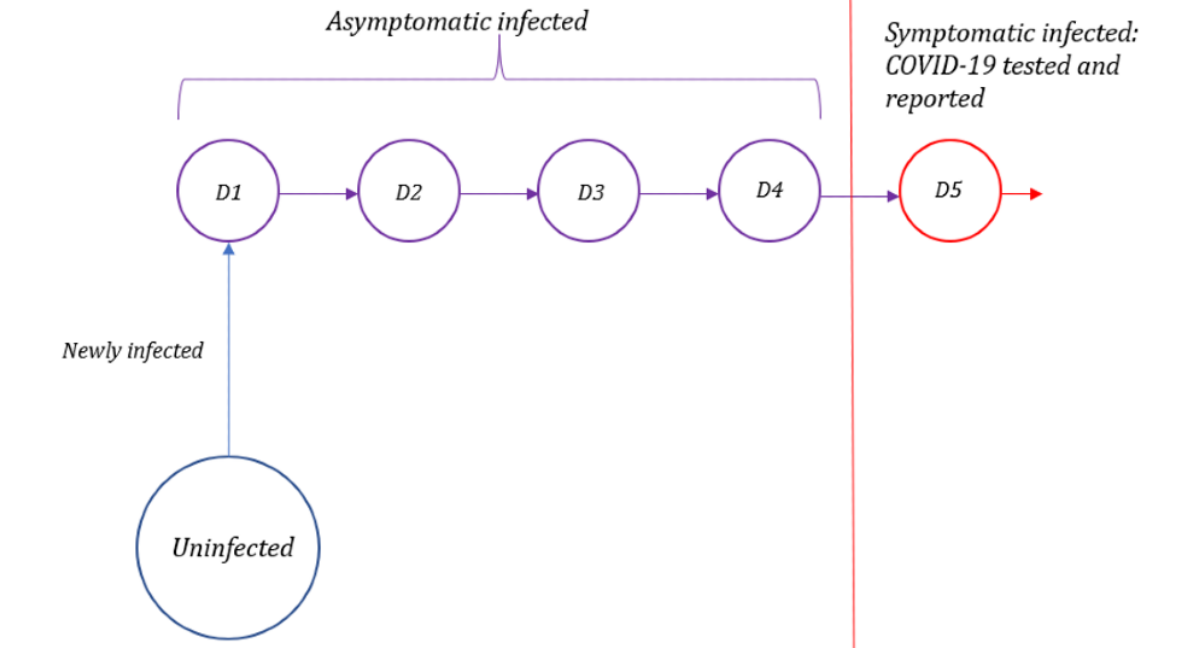
Figure 1. Timeline of infection for confirmed COVID-19 cases. After infection, an individual can transmit the infection to others but does not become symptomatic until day